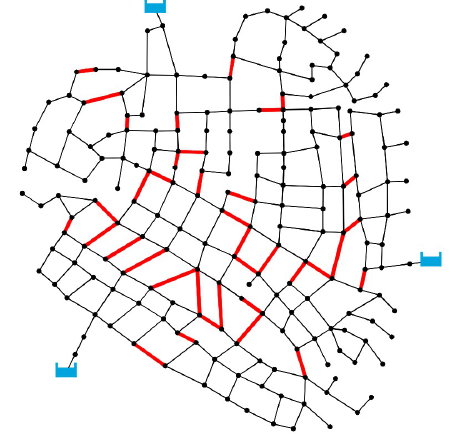
Figure 3. Conceptual cuts obtained for the three-reservoir network (TRN).